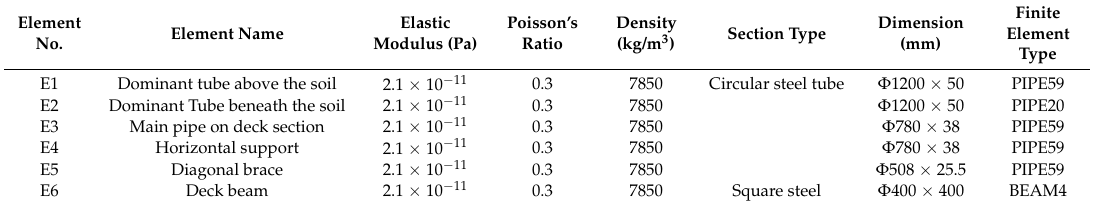
Figure 4. An offshore jacket platform. Table 1. Parameters of the structural model.